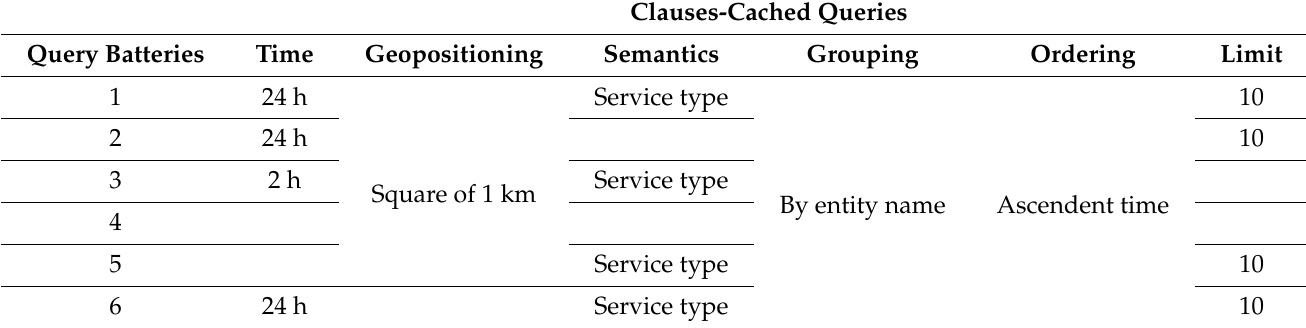
Table 5. Cached query sets.